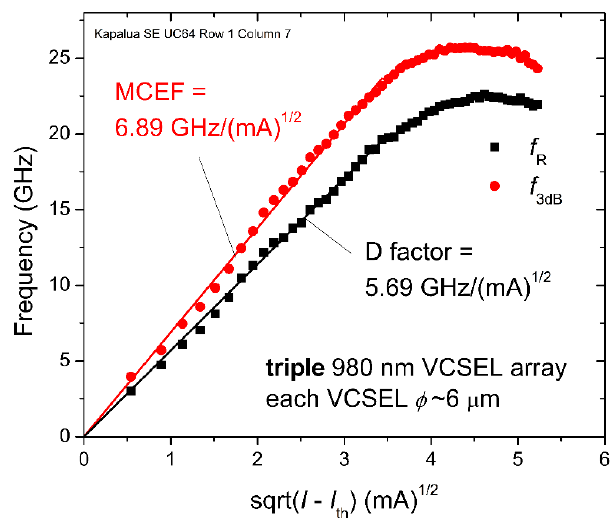
Figure 10. Measured − 3 dB bandwidth ( f 3dB ) and relaxation oscillation resonance frequency ( f R ) versus ( I − I th ) 1/2 for the 980 nm triple VCSEL array with ϕ ~ 6 μ m in Figure 9.